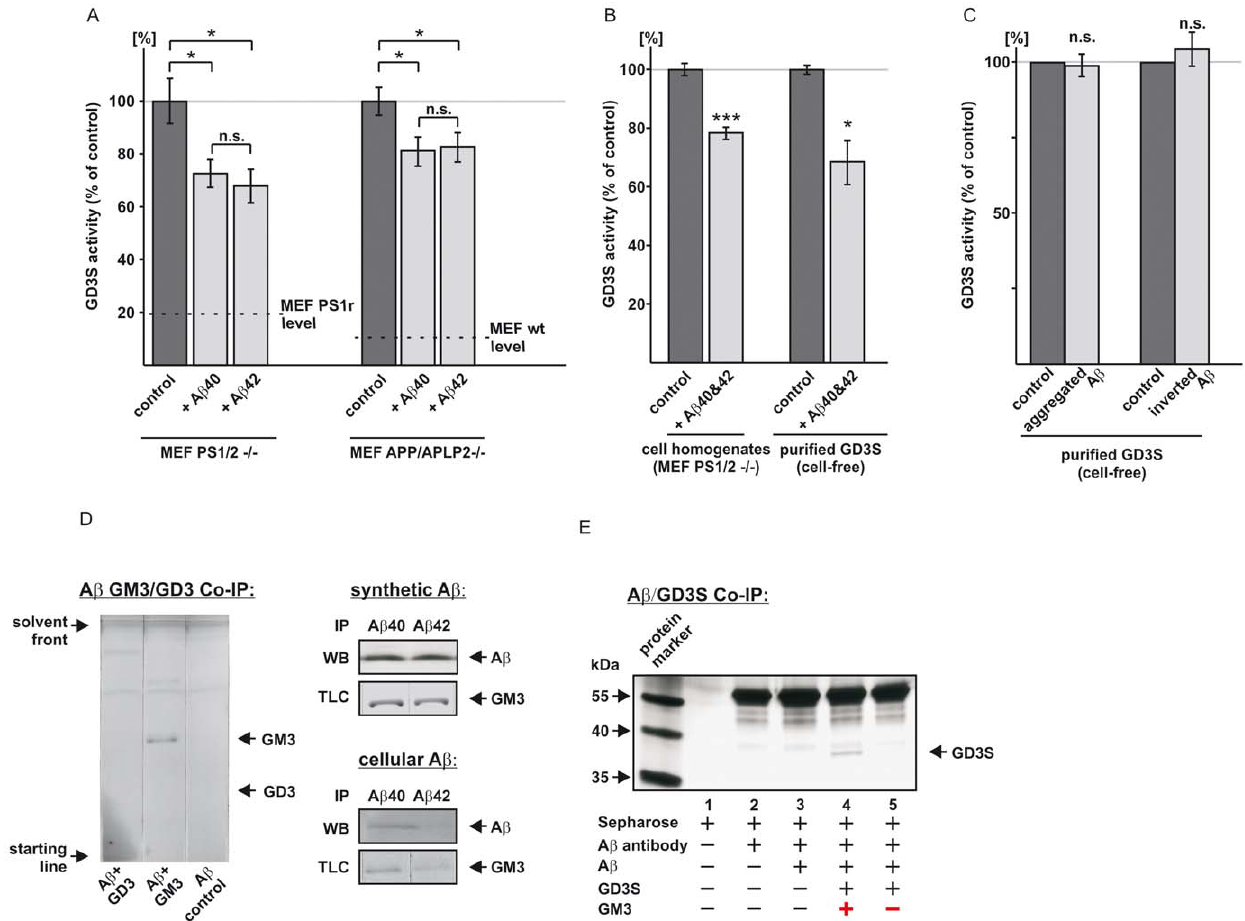
Figure 2. Influence of A b on GD3S activity. ( A ) Effect of A b on GD3S activity. MEF lacking A b because of PS- or APP-deficiency (MEF PS1/2-/- and MEF APP/APLP2-/-, respectively) were incubated with physiological A b 40 or A b 42 concentrations or the solvent used for the A b peptides (control). The level of the GD3S activity of the corresponding wildtype cells are indicated (horizontal dotted black line); corresponding wildtype/control cells for MEF PS1/2-/-: PS1/2 deficient MEF retransfected with PS1 (MEF PS1r); corresponding wildtype/control cells for MEF APP/APLP2: mouse embryonic fibroblasts of wildtype mice (MEF wt). Both A b species partially rescued the increased GD3S activity in PS- or APP-deficient MEF. No significant differences were observed between A b 40 and A b 42 peptides. ( B ) Direct effect of A b 40 and A b 42 on GD3S activity. Homogenates of PS1/2-/- cells incubated with A b 40 and A b 42 show decreased GD3S activity. Similar results are obtained with A b 40 and A b 42 in a cell-free assay containing only purified GD3S and the substrate GM3. ( C ) Influence of aggregated A b and inverted A b on GD3S activity. Inverted A b peptides and aggregated A b showed no influence on GD3S activity. ( D ) GM3, the substrate for GD3S, binds to A b : Physiological concentrations of cellular derived A b bind GM3 analyzed by co-immunoprecipitation (co-IP) of A b in presence of GD3 or GM3. GM3, but not GD3, binds to A b . After IP, A b bound gangliosides were detected via TLC. GM3 binds to synthetic A b 40 and A b 42 (shown for equimolar concentrations), and cellular derived A b 40 and A b 42 (shown for physiological concentrations, approx. 10:1 ratio). Thin black vertical lines (Fig. 2D left) indicate that the TLC plates were scraped to separate lines. ( E ) Co-IP of A b and GD3S in dependence of GM3. A b only binds to GD3S in presence of the substrate GM3. Data are represented as mean + / 2 SEM.